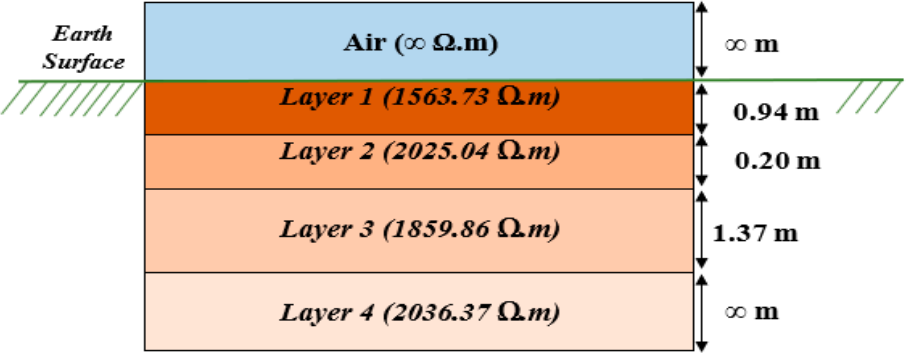
Figure 11. Tower T43 soil profile